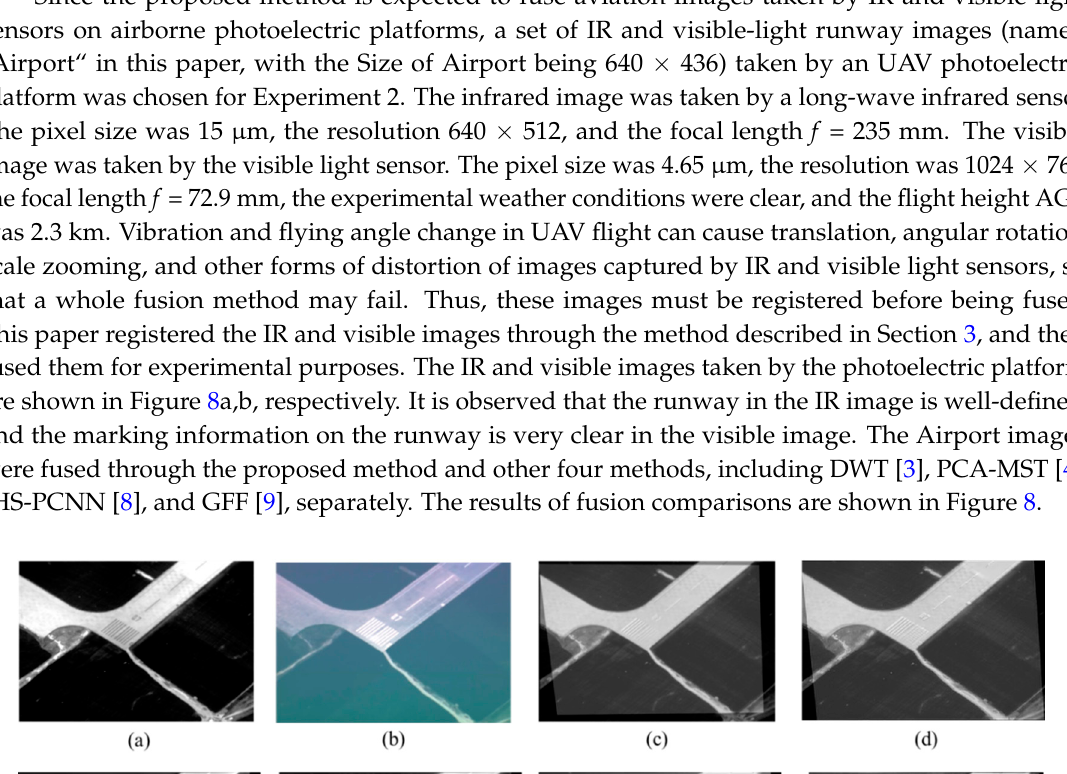
DWT [12]; ( e ) PCA-MST [22]; ( f ) GFF [24]; ( g ) IHS-PCNN [23]; ( h ) The proposed method.